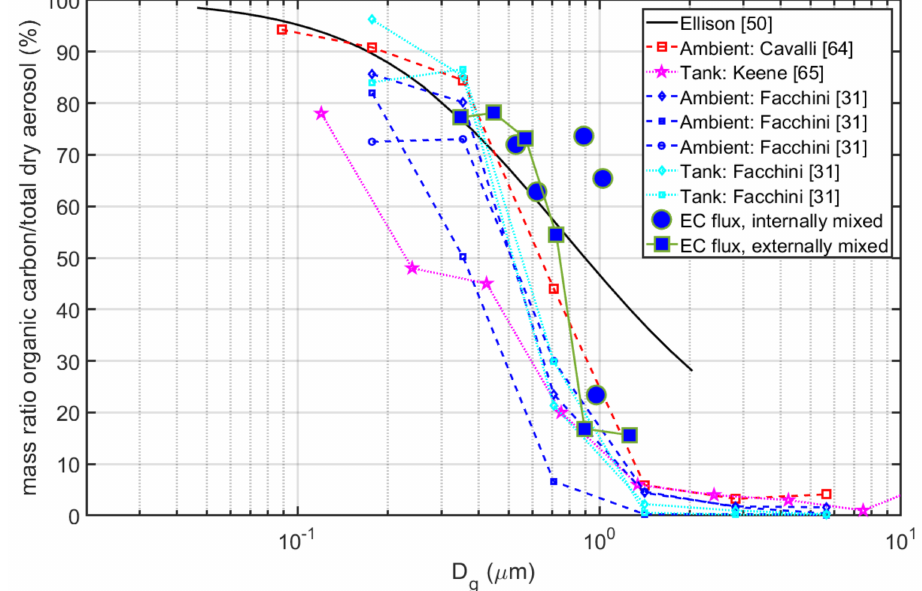
Figure 13. Estimates of the organic fraction of the sea spray emissions of the long fetch sector compared to other studies. The EC fluxes were used to form the ratio of the difference between dry (unheated) aerosol number flux and the heated non-volatile aerosol number flux, normalized by the dry unheated aerosol number flux (green lines with green circles and squares filled with blue), either on the basis of the assumption of an externally mixed sea spray (circles) or internally mixed sea spray (squares). Dashed curve with red squares from Cavalli [64] and based on in situ impactor data and chemical analysis of water-insoluble organic carbon and sea salt (the organic fraction divided by the sum of these two fractions) from the Irish Atlantic coast, Mace Head. The dotted magenta curve with stars is from Keene [65] and is based on mass spectrometer samples in tank experiments with in situ water near Bermuda. The dashed blue curves with diamonds, squares, or circles are from Facchini [31] using the same impactor, location, and chemical analysis as Cavalli [64]. The dotted cyan curves with diamonds and squares are taken simultaneously to the dashed blue curves with similar impactor and chemical analysis, but the impactor was connected to our sea spray simulation tank on board the RV Celtic Explorer on the North East Atlantic upwind from Mace Head. The full black curve shows the ratio between organic carbon and the sum of organic carbon and sea salt based on applying the conceptual model by Ellison [50] (a monolayer of organic surfactants on the original sea spray